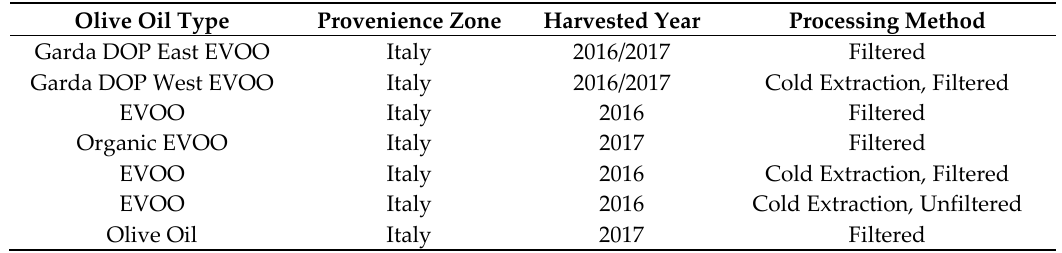
Table 2. Description of olive oil samples in relation to type, provenience zone, harvested year, and processing